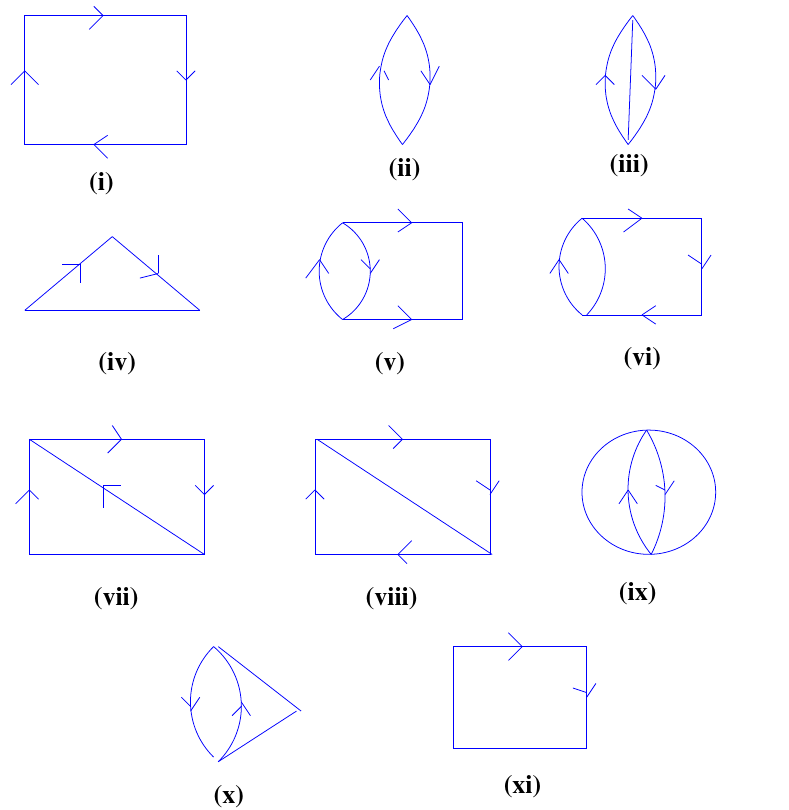
Figure 14 . The graphs (i) Q 1 , (ii) Q 2 , (iii) Q 3 , (iv) Q 4 , (v) Q 5 , (vi) Q 6 , (vii) Q 7 , (viii) Q 8 , (ix) Q 9 , (x) Q 10 and (xi) Q 11